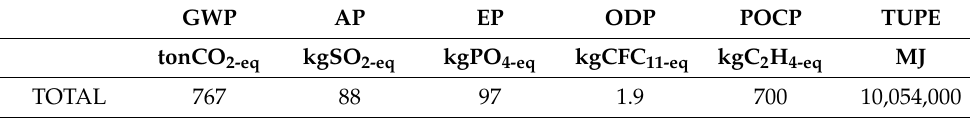
Table 11. Global LCIA